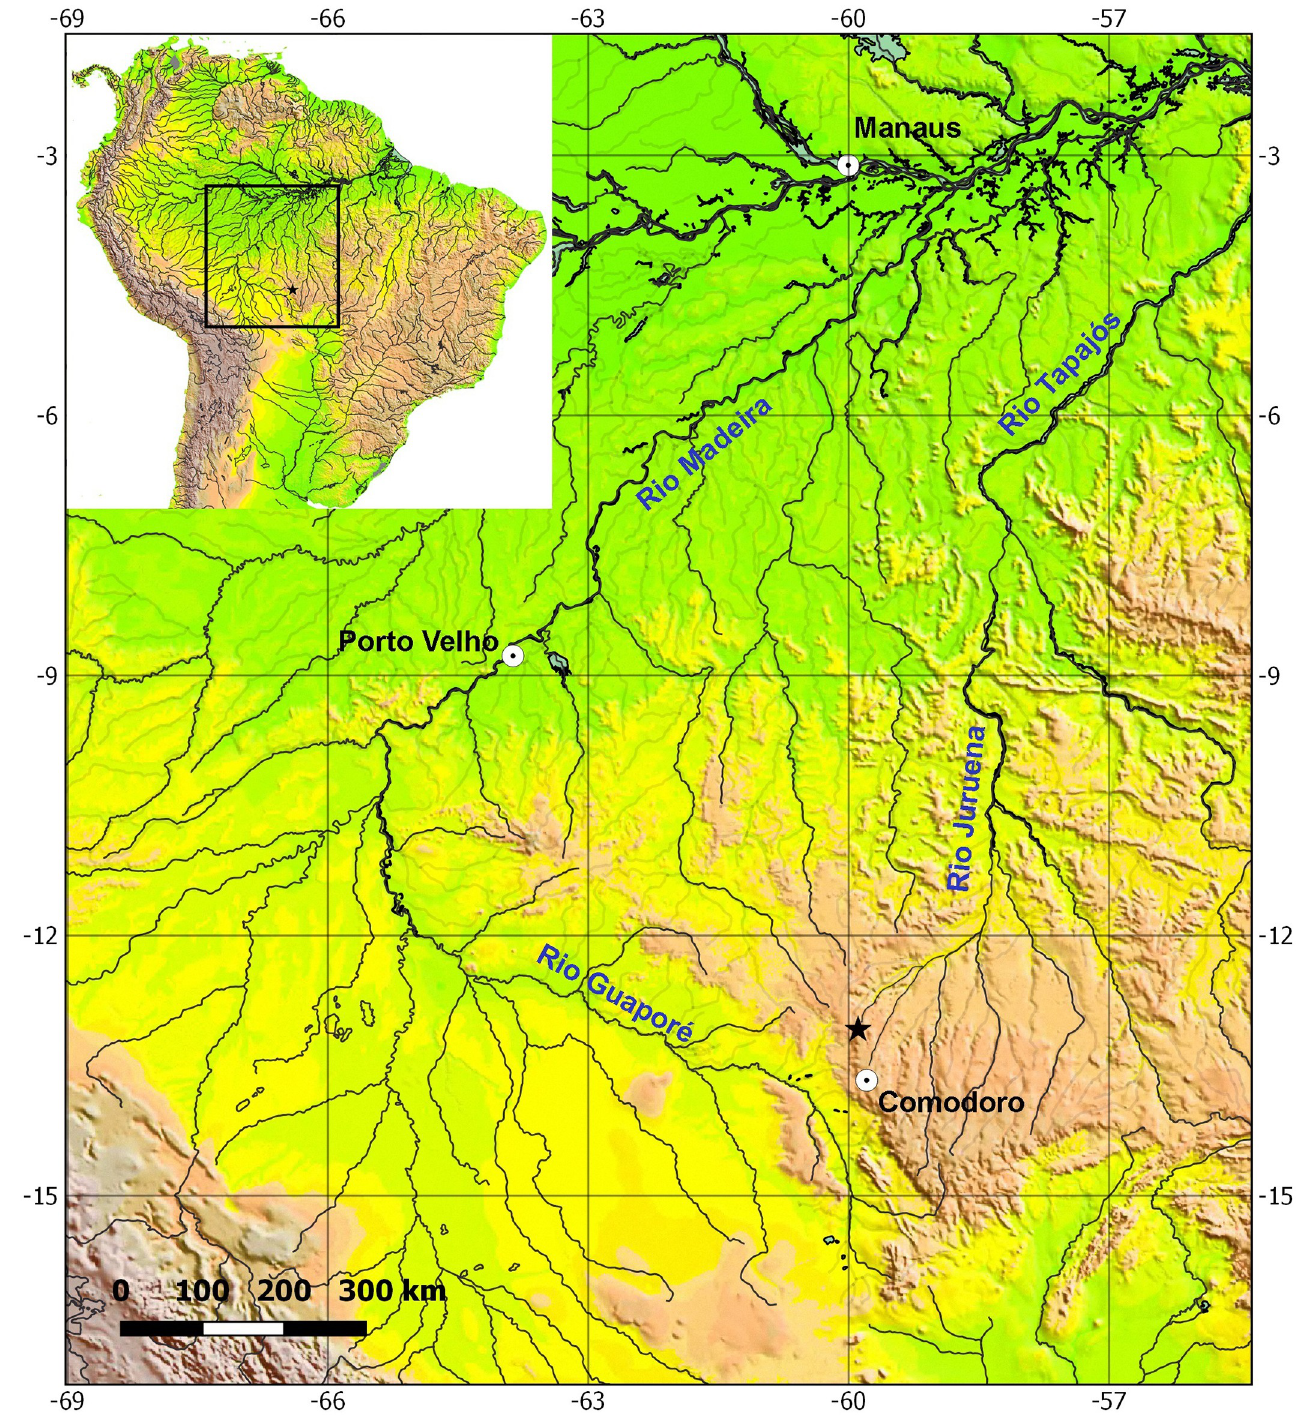
Fig 9. Map of the upper portion of rio Tapajo´s basin, showing the locality of Eigenmannia sirius . Star represents more than one lot.